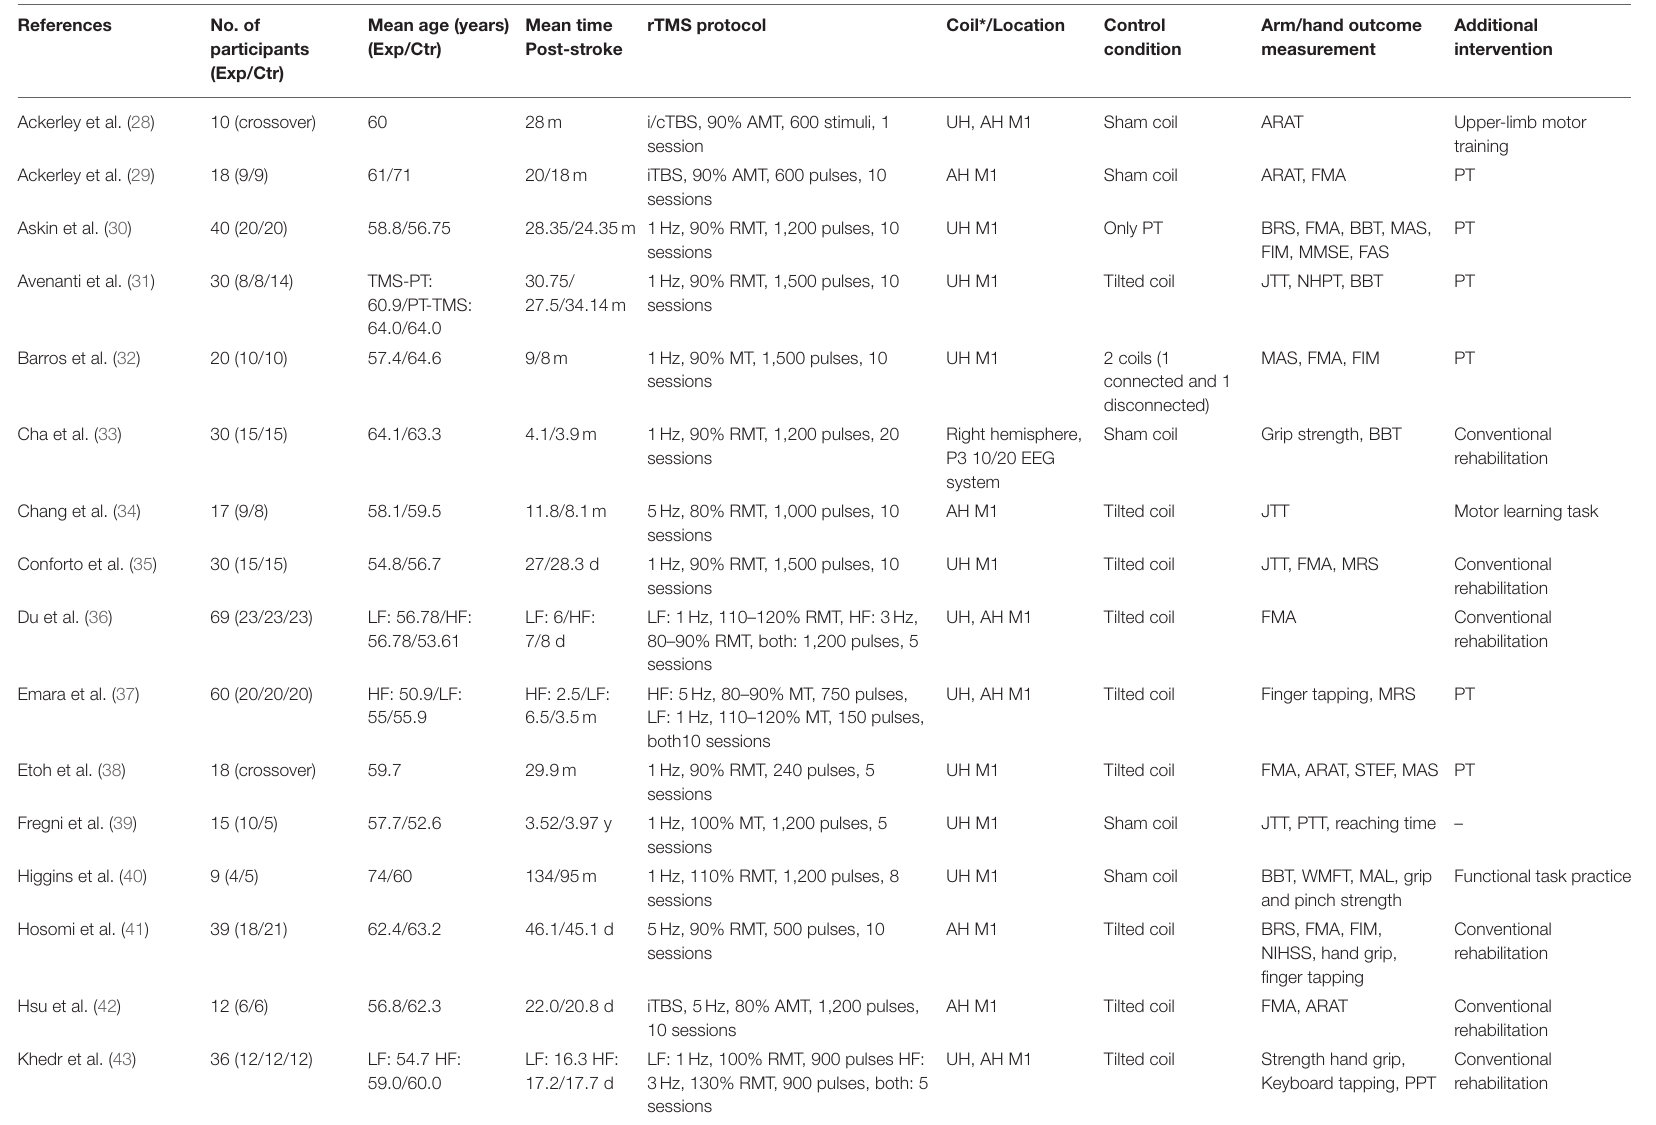
TABLE 1 | Characteristics of the included